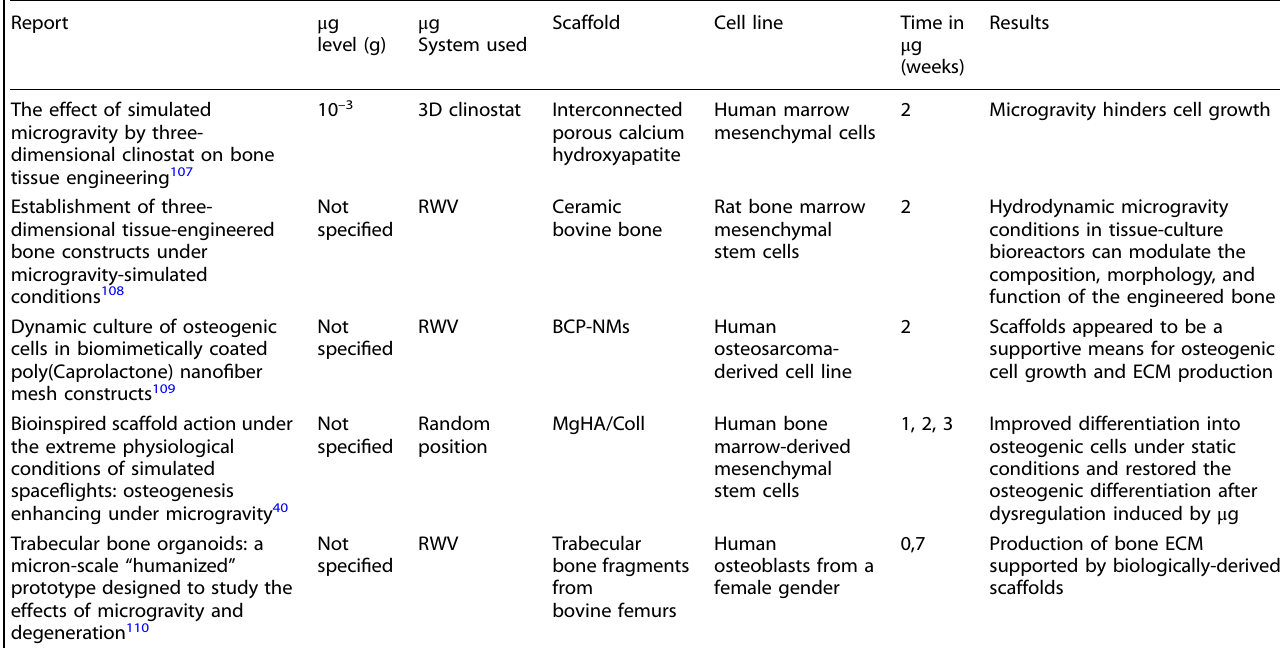
Table 5. Summary of the collected biological responses in simulated